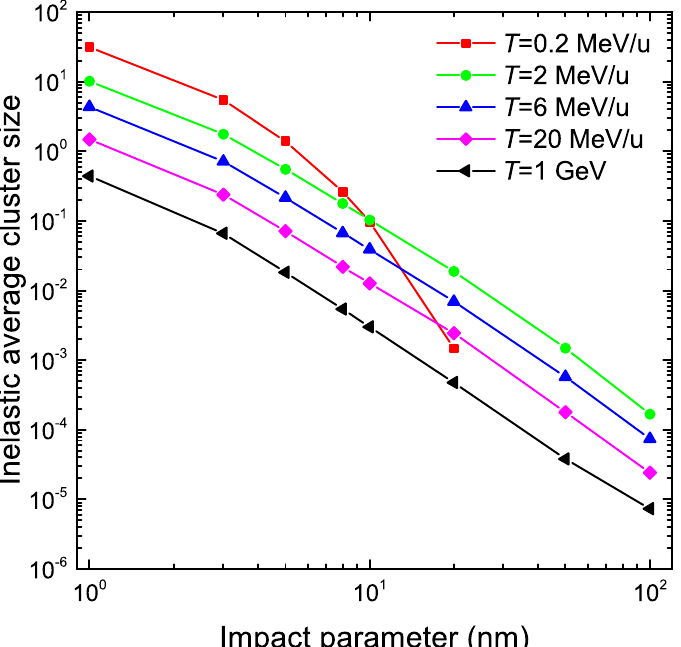
Figure 13. Average cluster size in a sensitive volume of liquid water having the dimension of two DNA turns, as a function of the impact parameter r from the ion path, for different values of the carbon ion energy T . Ionisations, dissociative excitations and dissociative electron attachments events are taken into account.